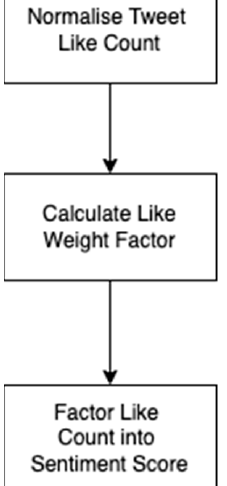
Figure 11. Deep Learning System flow chart.